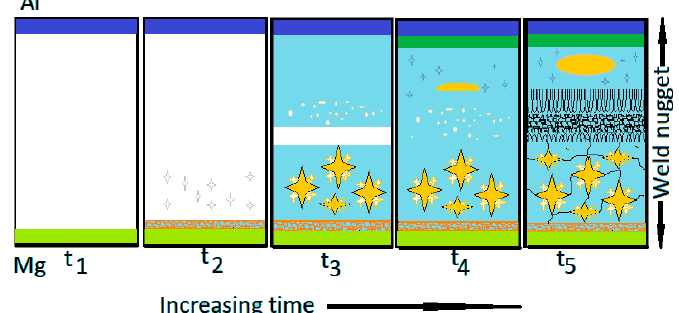
Figure 12. Schematic of the development of the solidification structure within the weld nugget as a function of time.